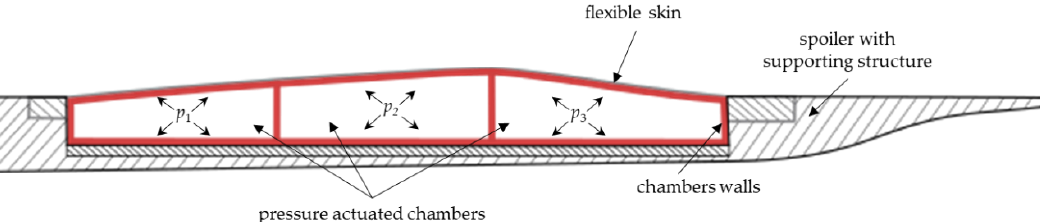
Figure 9. Adaptive spoiler with pressurized chambers and various pressures ( p ) for shock control bump generation based on [76].